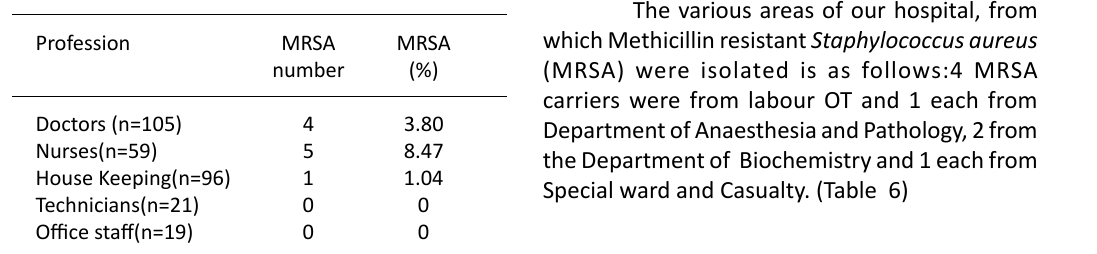
Table 5. Isolation rate of MRSA in